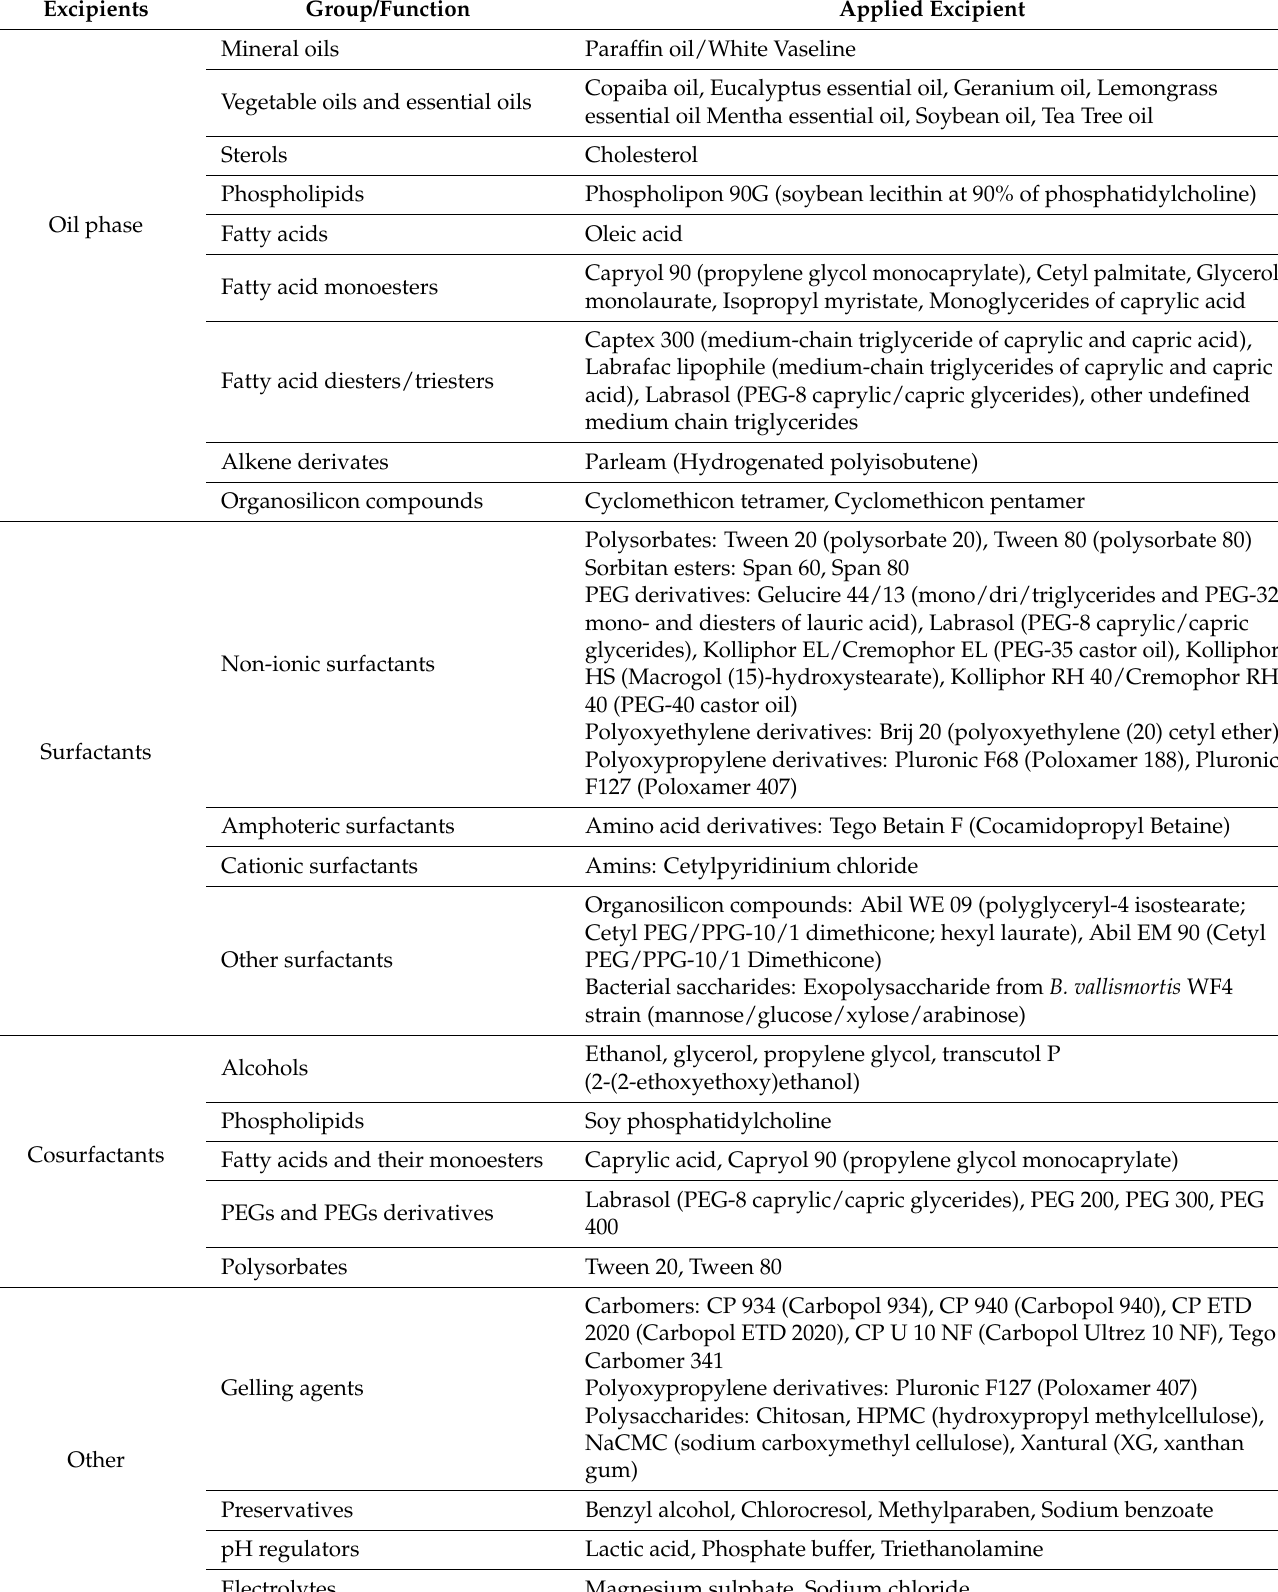
Table 3. Excipients used as the components of emulsion-based vaginal drug formulations